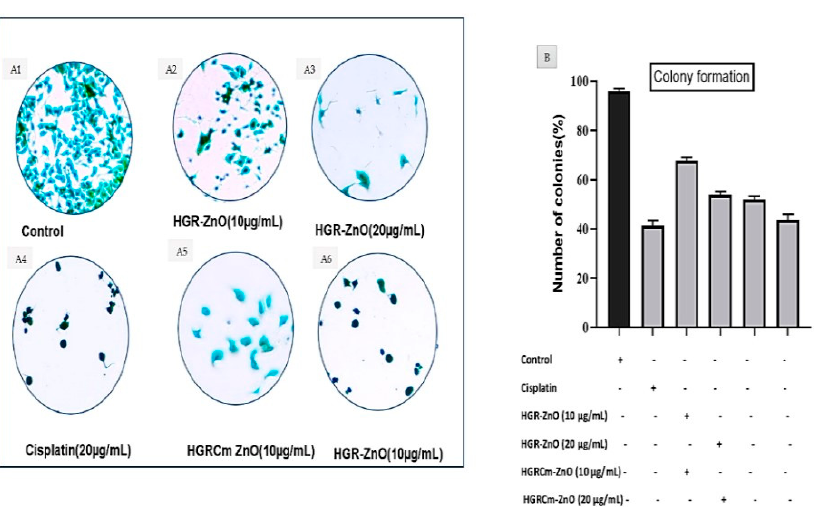
Figure 5. The colony formation assays. ( A ) The representative image of the colony formation after being stained with crystal violet of HGRCm-ZnO NPs at 10 and 20 µ g/mL. Cisplatin was used as a positive control. ( B ) The number of colonies was counted using Image J analysis software, and the results are presented in graph.